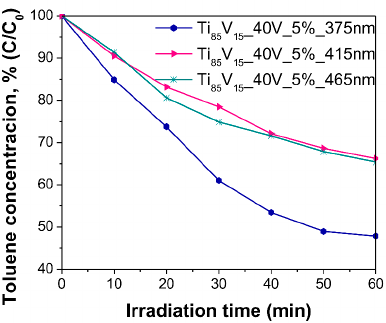
Figure 9. Photoactivity of Ti 85 V 15 _40V_5% sample in gas phase degradation of toluene under different wavelengths of irradiation ( λ max = 375, 415, 465 nm).